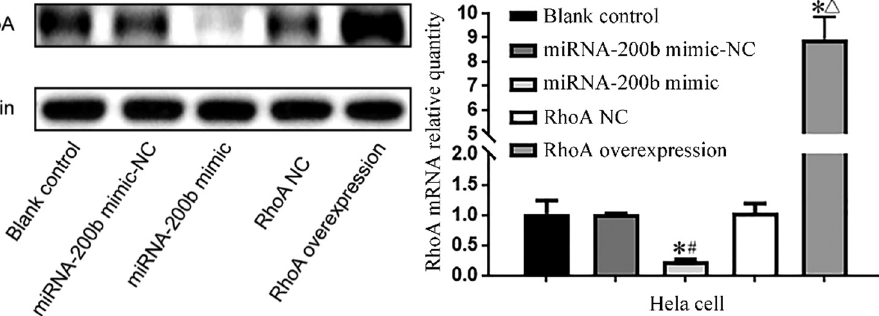
Figure 3: RhoA protein and mRNA expression levels of Hela cells in each group. Note: compared with blank control group, * P < 0.05; compared with miRNA - 200b mimic - NC group, # P < 0.05; and compared with RhoA NC group, Δ P <